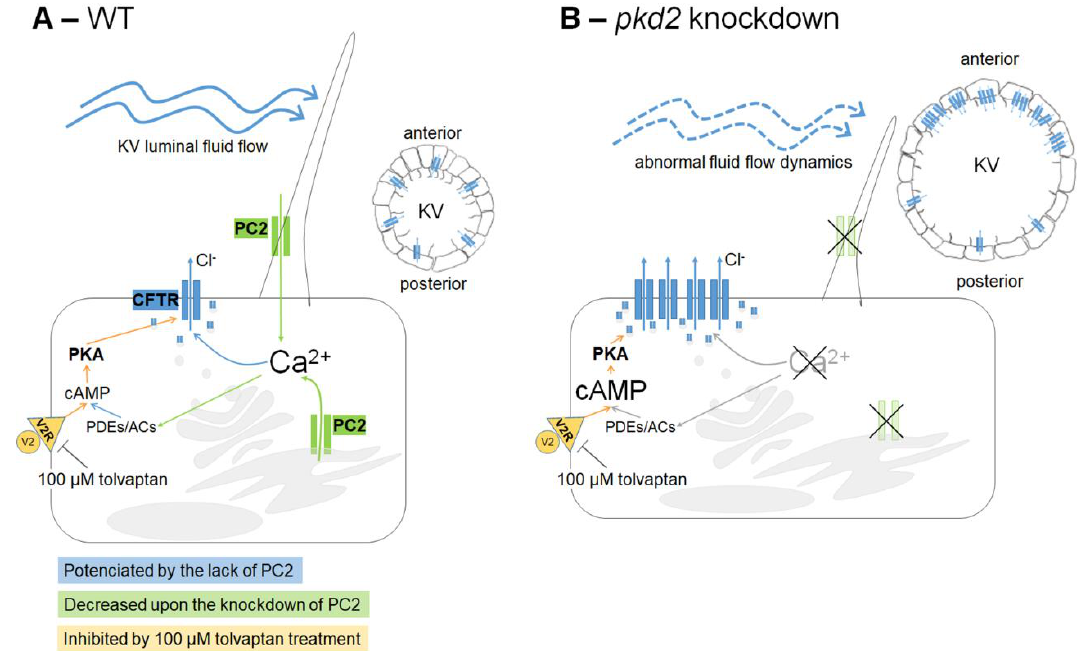
Figure 6. Working model of the cross-talk between PC2 and CFTR in the KV inflation. ( A ) As in kidney cysts, we extrap- olate that in WT KV epithelial cells, once stimulated by the luminal fluid-flow, PC2 raises intracellular Ca 2+ transients. These should maintain the basal intracellular levels of cAMP, through regulation of Ca 2+ -dependent adenylyl cyclases (ACs) and phosphodiesterases (PDEs). cAMP is required for the normal rate of CFTR activity. This ensures the CFTR- mediated transport of Cl − and subsequent movement of water into the KV lumen, allowing its inflation. Additionally, cAMP levels are also dependent on V2R since we know that its pharmacological inhibition by 100 µM tolvaptan impairs the KV inflation. ( B ) The knockdown of pkd2 changes several variables of the KV: volume enlargement [27], different cell shapes [27] and, therefore, different architectures with the consequent loss of the anterior cilia cluster [27,34], shorter cilia [34], and weakened and homogeneous luminal flow [34]. The lack of PC2 should lower the intracellular levels of Ca 2+ , which, through still unknown mechanisms, leads to a significant increase of CFTR expression at the apical region of the cell (membrane and subapical zone), namely in the anterior part of the KV. This justifies the CFTR-mediated KV enlarge- ment observed upon lack of PC2. It is still unknown if the resulting raise in the cAMP levels, induced by the low Ca 2+ levels, further potentiates the CFTR activity. However, mimicking a kidney cyst, pharmacological inhibition of KV V2R by 100 µM tolvaptan was enough to rescue the KV enlargement of these embryos. 3. Materials and Methods 3.1. Fish Strains The two following zebrafish lines, both of AB background, were used for this work: a KV reporter line Tg(sox17:GFP)s870 [42] and a CFTR-GFP transgenic line, the TgBAC(cftr-GFP)pd1041 [28]. Zebrafish adults were maintained at 28 °C. Embryos ob- tained from incrosses were incubated in E3 medium at 25 °C or 28 °C and staged as de- scribed elsewhere [43]. 3.2. Morpholino Microinjections The knockdown of PC2 was induced using the previously reported pkd2 -augMO [27,35,36]. We injected 1.8 ng into one-cell stage zebrafish embryos and 1.8 ng of a mis- matchMO was used as control. Both morpholinos were purchased from Gene Tools LLC (Philomath, OR, USA). Additionally, 1000 pg of Xenopus pkd2 mRNA was injected at the one-cell stage in combination with pkd2 -augMO, to try to rescue the KV enlargement caused by the latter. 3.3. Pharmacological